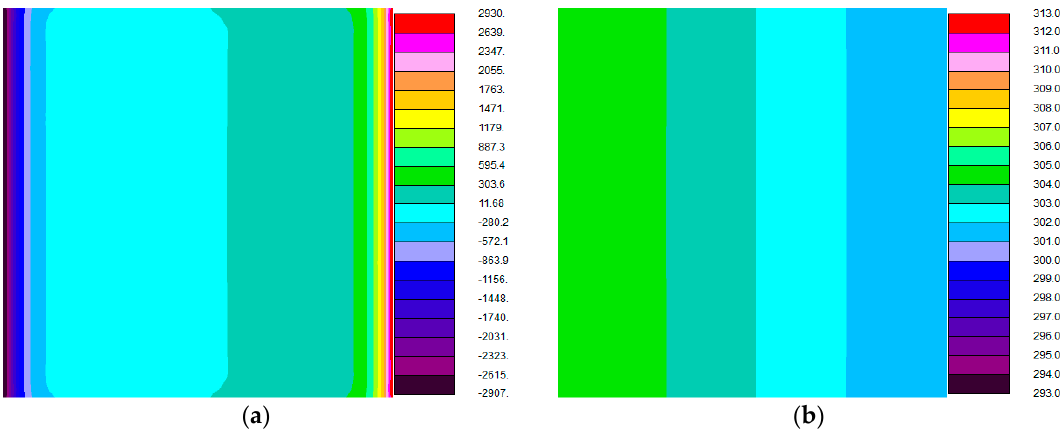
Figure 14. Counter-flow brass plate heat exchanger heat transfer model with LHC ( a ) The plate LHC heat flux distribution; ( b ) The plate temperature distribution.